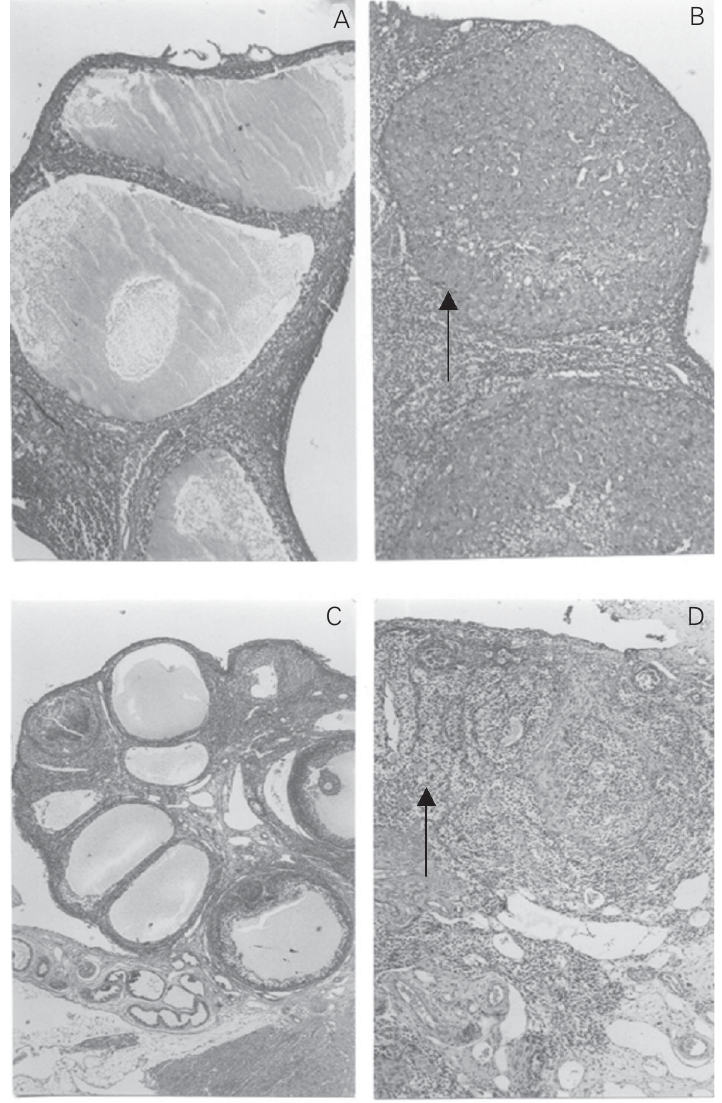
Figure 4. Ovaries from group IV rats (continuous light ovariectomized melatonin- treated group). The induction and regression of polycystic ovaries before (A,C) and after (B,D) melatonin replacement is indicated by an important reduction of ovarian cysts and by the presence of corpora lutea (B) and by interstitial tissue proliferation (D) as indicated by arrows. Hematoxylin and eosin (±